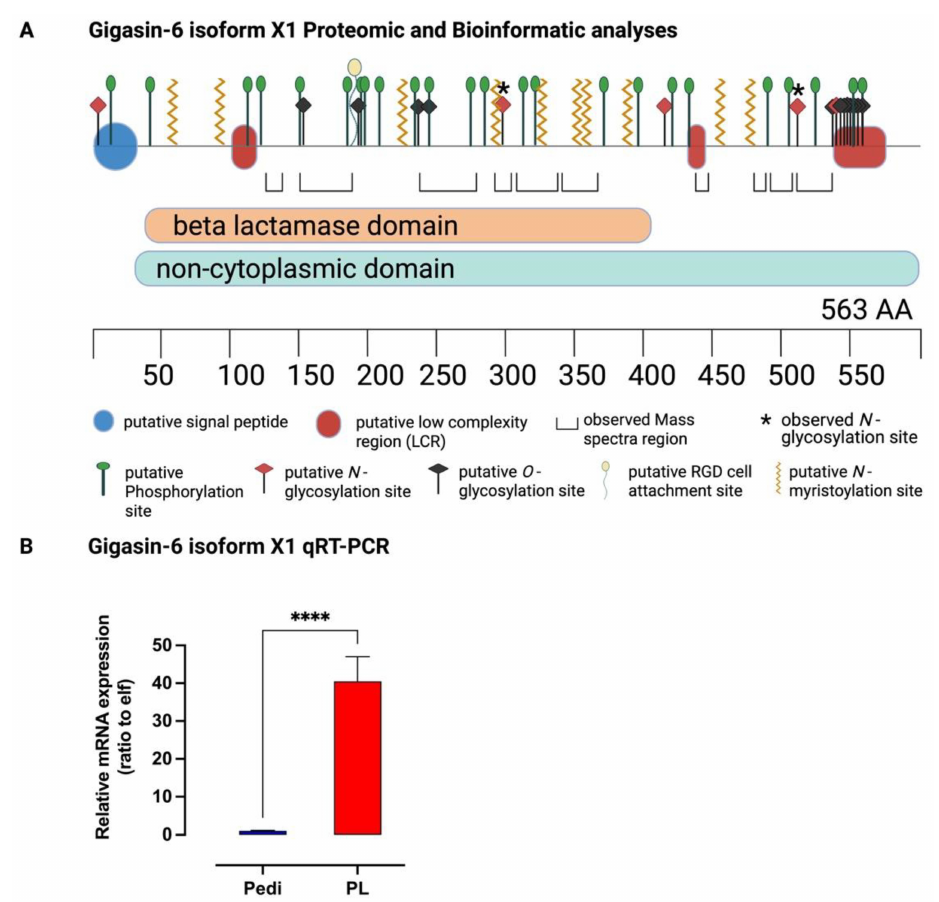
Figure 5. Molecular characterization of Gigasin-6 isoform X1. ( A ) Graphical representation showing its protein length, signal peptide, putative domains, motif, and post-translational modifications identified by mass spectrometry and bioinformatic analyses. The putative phosphorylation sites (24 out of 70) in this model highlight those which may be involved in signal-transduction processes. The observed region indicates the location of the mass spectra identified by mass spectrometry analysis. Figure 5A was created using BioRender.com, accessed on 25 July 2022. ( B ) Relative mRNA expression levels of Gigasin-6 isoform X1 gene before (Pediveliger, Pedi) and after (postlarvae, PL) settlement induction by the CgSE using quantitative real-time PCR. Data are expressed as the mean (SD) ( n = 3). Values with “****” are significantly different ( p < 0.0001). Figure 5B was created using GraphPad 9 software